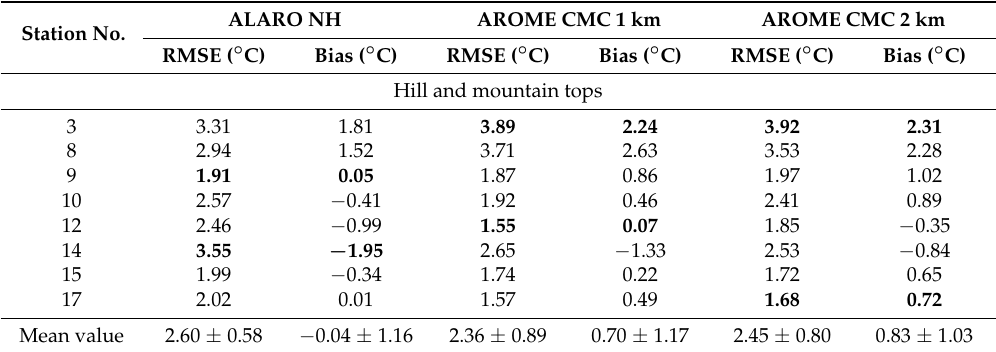
Table 11. Comparison of ALARO NH and AROME CMC 1 km kilometric scale models and AROME CMC 2 km operational